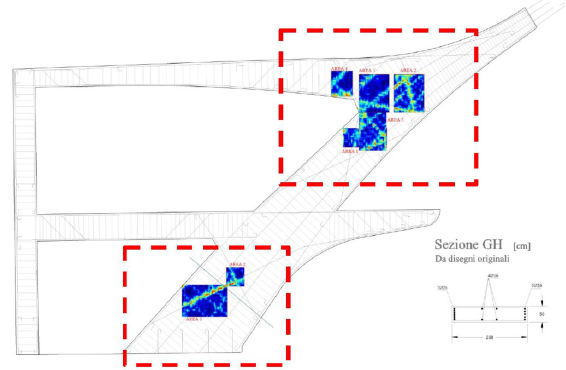
Figure 2 . Overlapping of the reinforcement detected by georadar with respect to the reinforcement as it was designed by Pier Luigi Nervi.